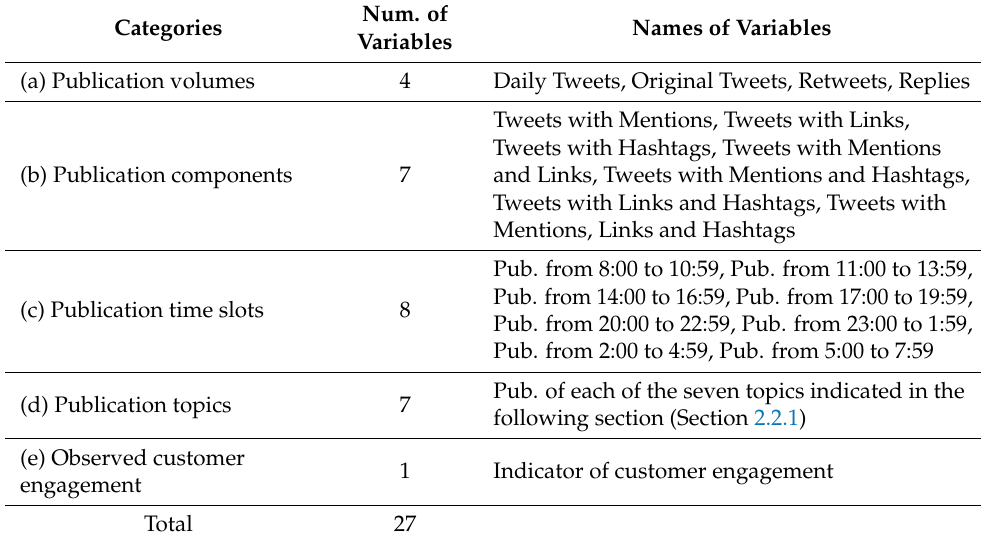
Table 2. Variables extracted from the